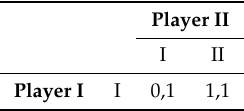
Table 11. An example where J